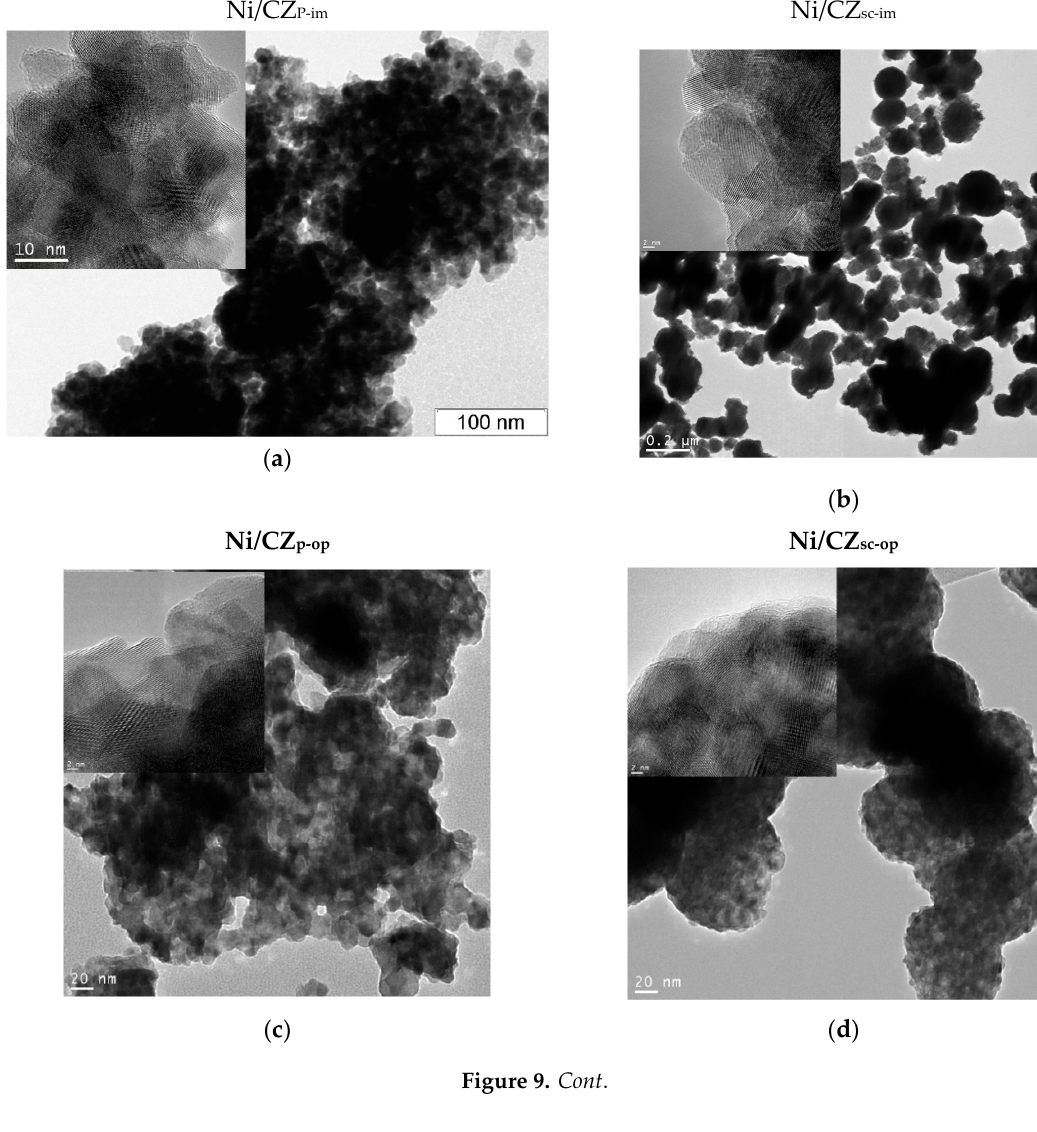
( f ) Figure 9. TEM images of impregnated ( a ),( b ) and one-pot ( c ),( d ) 5% Ni/Ce 0.75 Zr 0.25 O 2 prepared using the Pechini route ( a ),( c ) and supercritical synthesis ( b ),( d ) and Ti-doped catalysts ( e ),( f ) prepared in supercritical alcohols.